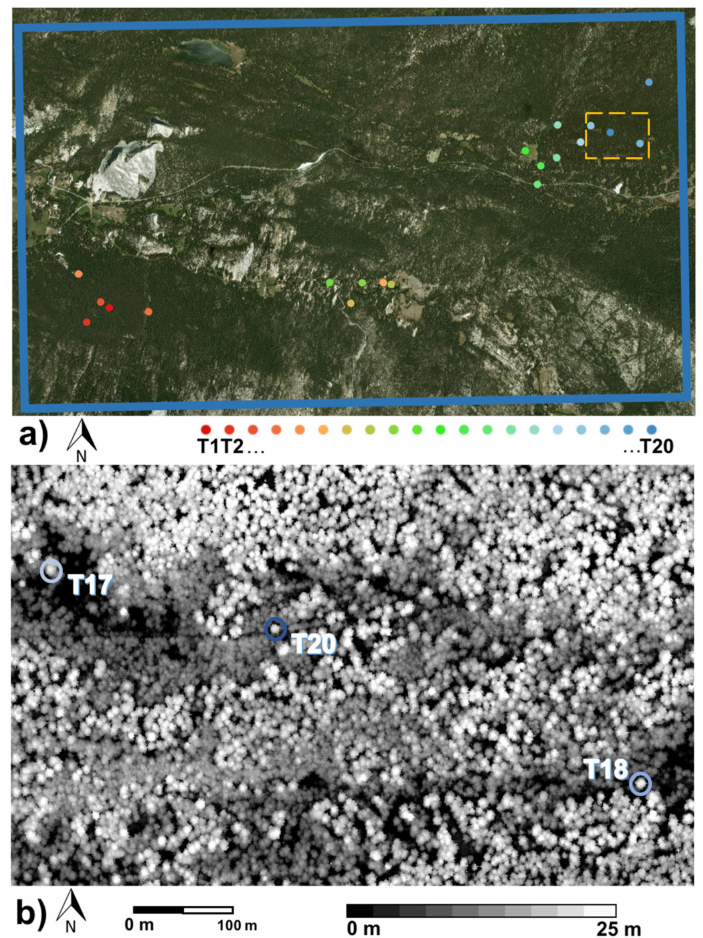
Figure 4. Tuolumne River basin ( a ) study site (7 km × 4 km) that corresponds to the blue polygon in Figure 1b and the 20 tie objects trees (T1, T2, . . . , T20) selected for point cloud registration purposes represented by the colored dots and, ( b ) focus on the orange rectangle in ( a ) to show three tie object examples over a canopy height model. The colorbar in panel ( b ) corresponds to the vegetation